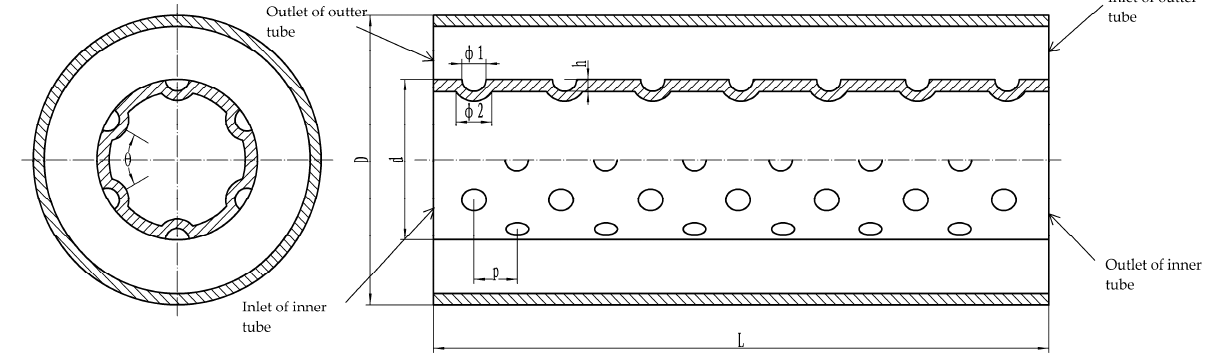
Figure 1. Structure of dimpled heat exchange tube.